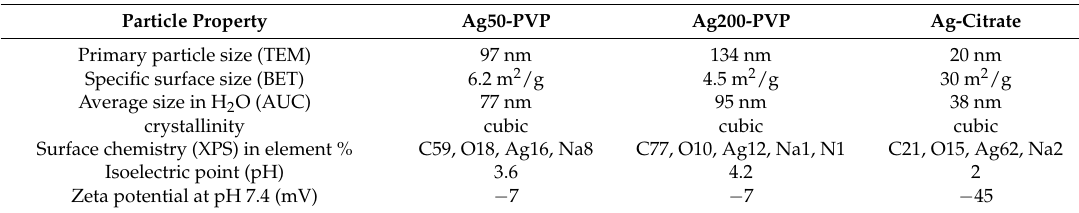
Table 2. Particle